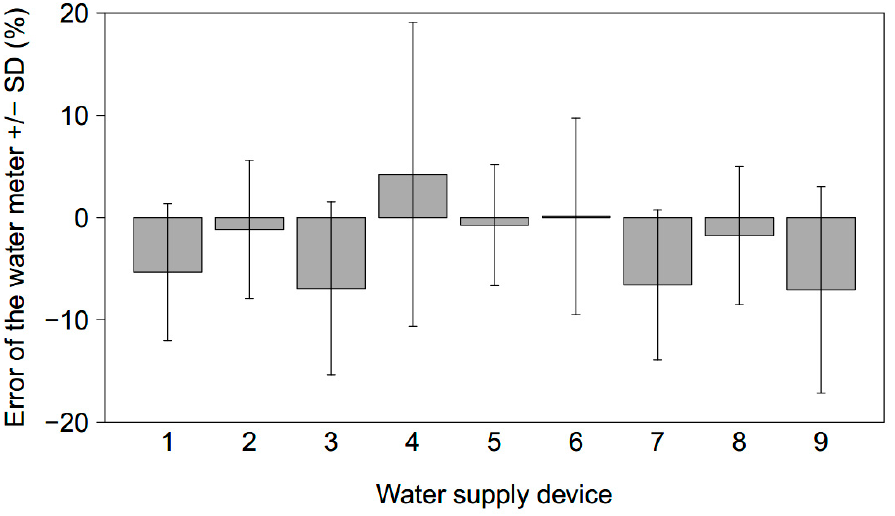
Figure 6. Mean error of each water meter with standard deviation for 9 connected devices which were refilled simultaneously. N = 10 for each device.